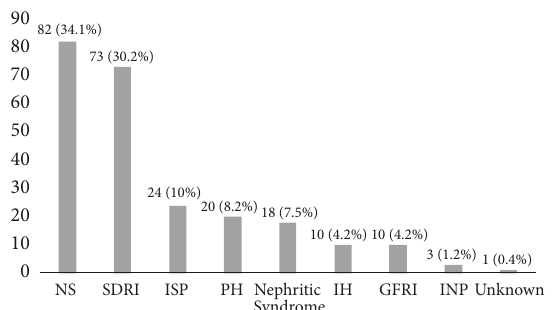
Figure 1: Renal biopsy indications. NS: nephrotic syndrome; SDRI: Systemic disease with renal involvement; ISP: isolated subnephrotic proteinuria; PH: proteinuria and hematuria; IH: isolated hematuria; GFRI: glomerular filtration rate impairment without a known cause; INP: isolated nephrotic proteinuria. Table 2: Kidney disease stage and associated systemic disease.